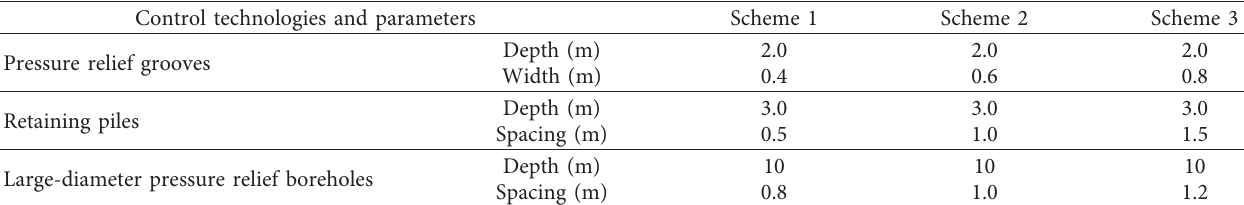
Figure 5: Large-diameter pressure relief drilling schematic diagram of solid coal side. (a) Sectional drawing; (b) vertical view. Table 1: Numerical simulation scheme for control scheme of floor